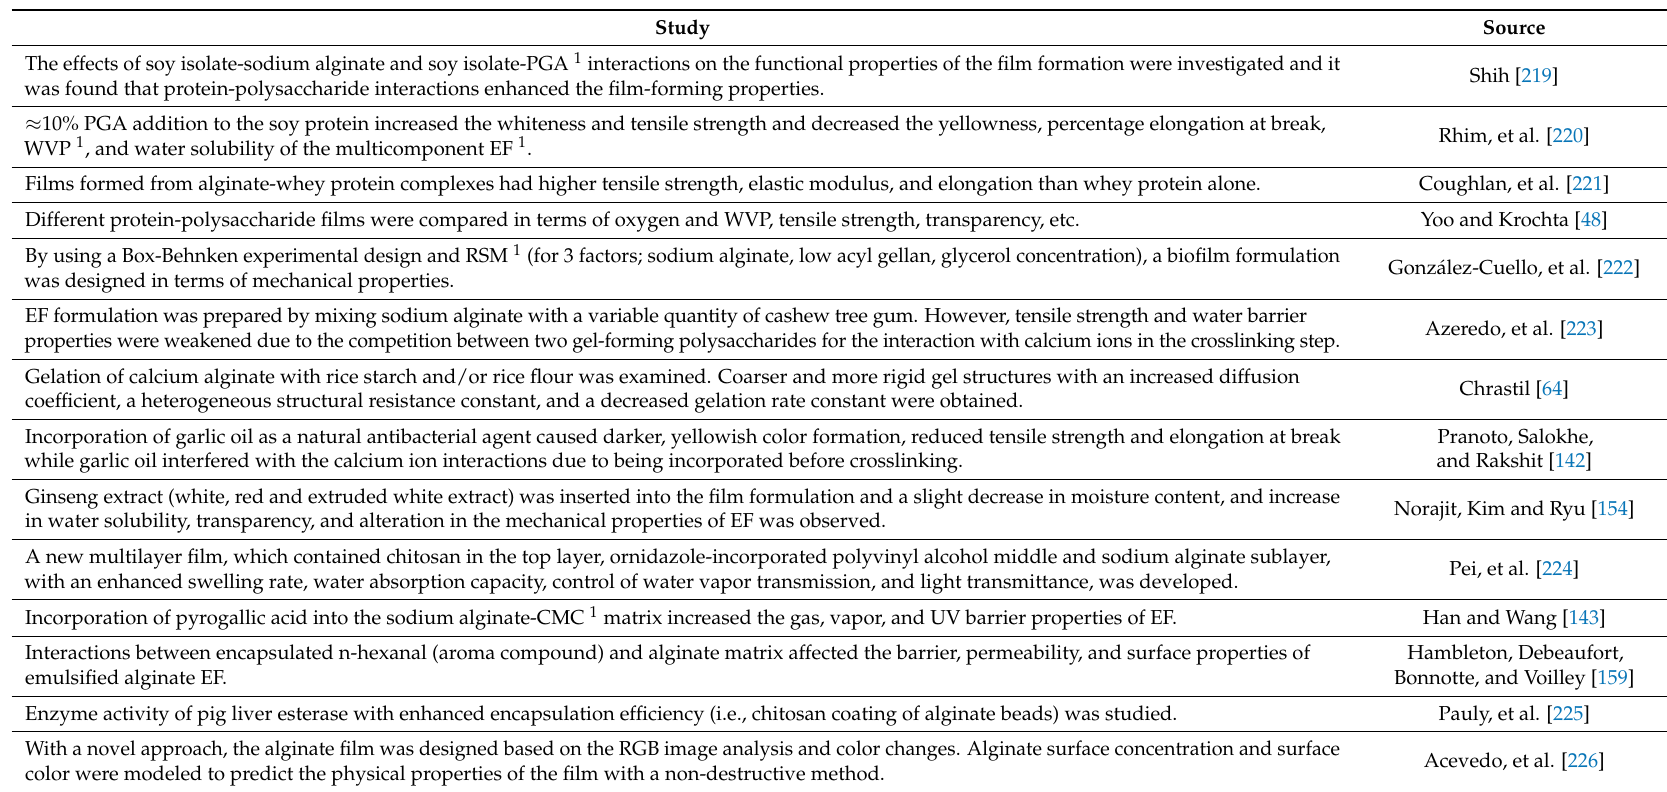
Table 5. The studies on alginate-based coatings/films without food